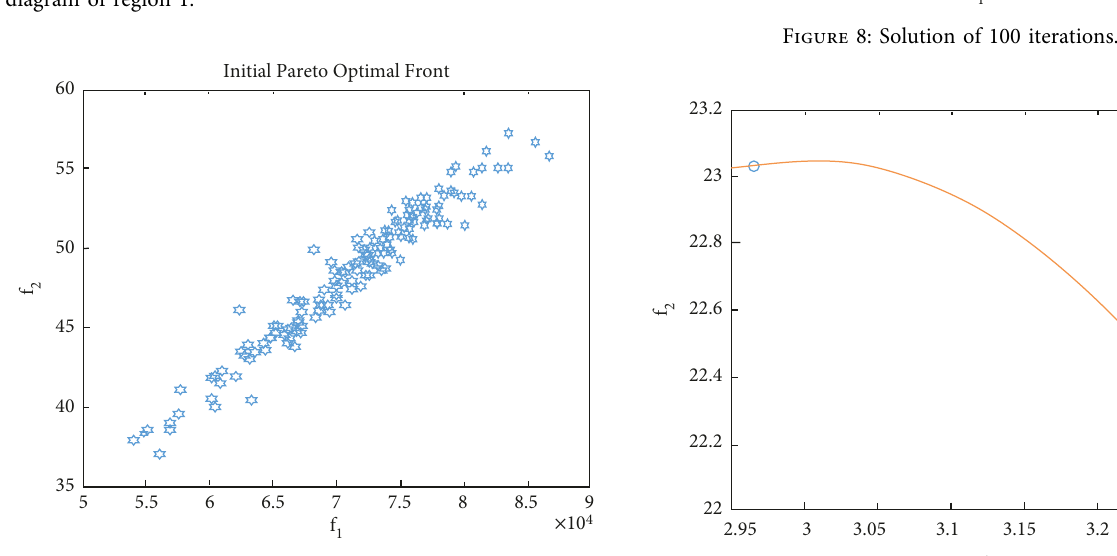
Figure 7: Solution of the initial population.